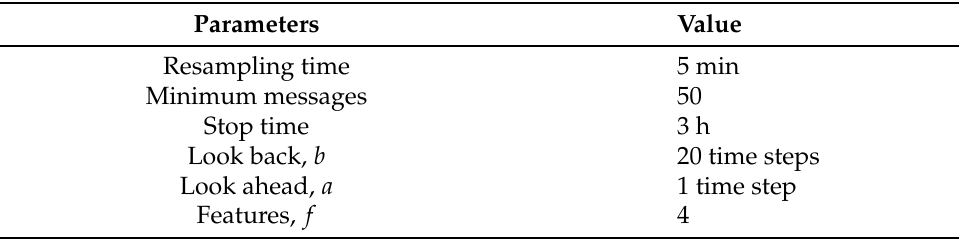
Table 2. Data pre-processing values. With Look ahead of 1 time step, we are only prediction the location 5 min into the future.